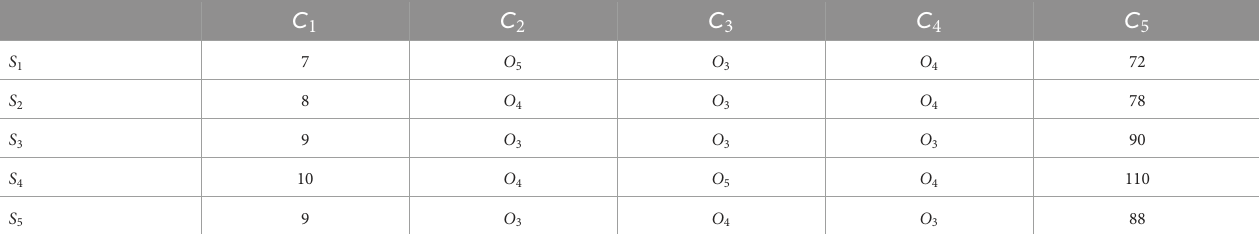
TABLE 3 Assessment level of doctors.